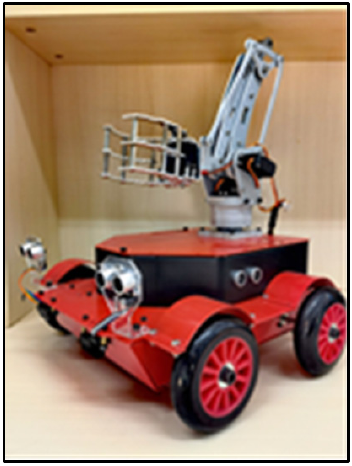
Figure 2. Overall picture of the car body.